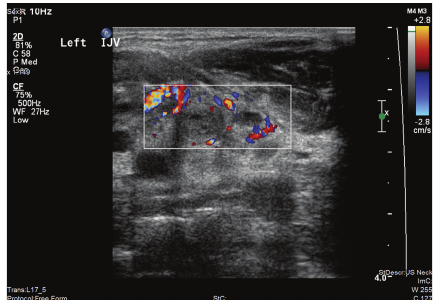
Figure 3: Doppler ultrasound of the neck showing the thrombus in the internal jugular